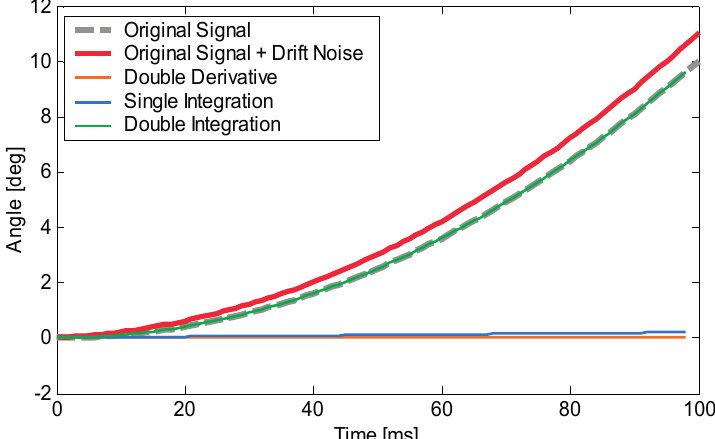
Figure 2. Simulation of the DDI method. The vertical axis represents the angle and horizontal axis represents time. The grey broken line represents the original signal and the red line represents the signal model with linear drift noise. The signal processed after double derivative, single integration and double integration are represented by the orange, blue and green lines,